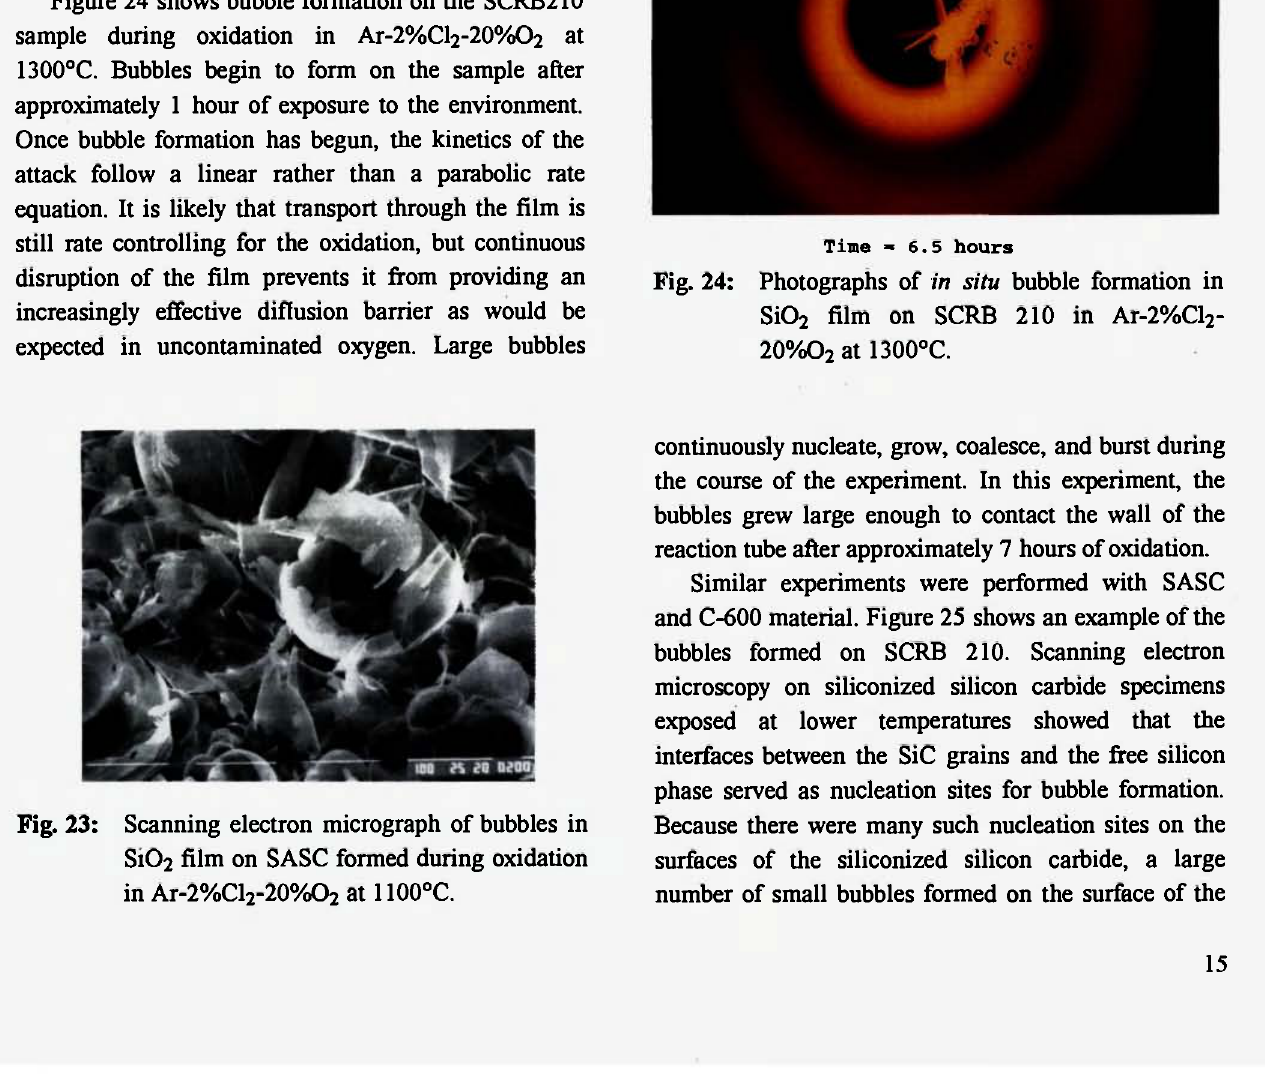
Fig. 24: Photographs of in situ bubble formation in Si0 film on SCRB 210 in Ar-2%C1 2 20%0 at 1300°C. 2